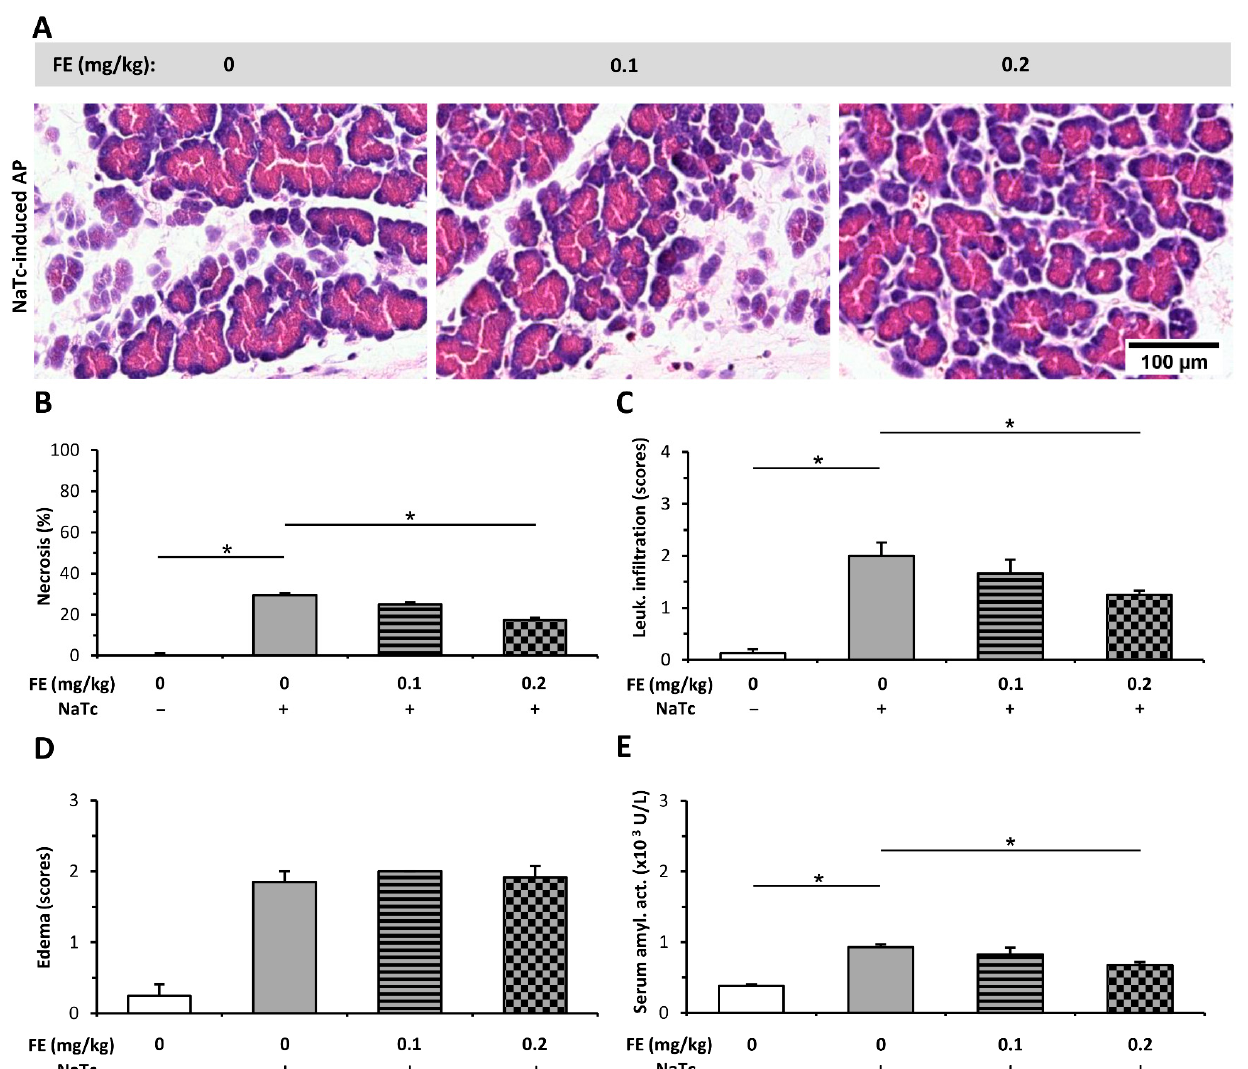
Figure 4. Fentanyl (FE) treatment started after the induction of necrotizing acute pancreatitis (AP) with sodium taurocholate (NaTc) reduces disease severity. Rats were treated with 0.1 or 0.2 mg/kg FE i.p., whereas the intra-ductal injection of 40 mg/kg NaTc (NaTc +) was used to induce AP. Control animals received physiological saline instead of NaTc (NaTc − ) or FE (0 mg/kg). Animals were sacrificed at 16–24 h after the NaTc or physiological saline injection. ( A ) Representative histopathological images of pancreatic tissues of the treatment groups. Bar charts show the extent of pancreatic ( B ) necrosis, ( C ) leukocyte infiltration, ( D ) edema, and ( E ) serum amylase activity measurements. Values represent mean with standard error, n = 9–12. Two-way ANOVA was performed followed by the Holm–Sidak post hoc test. * p < 0.05.